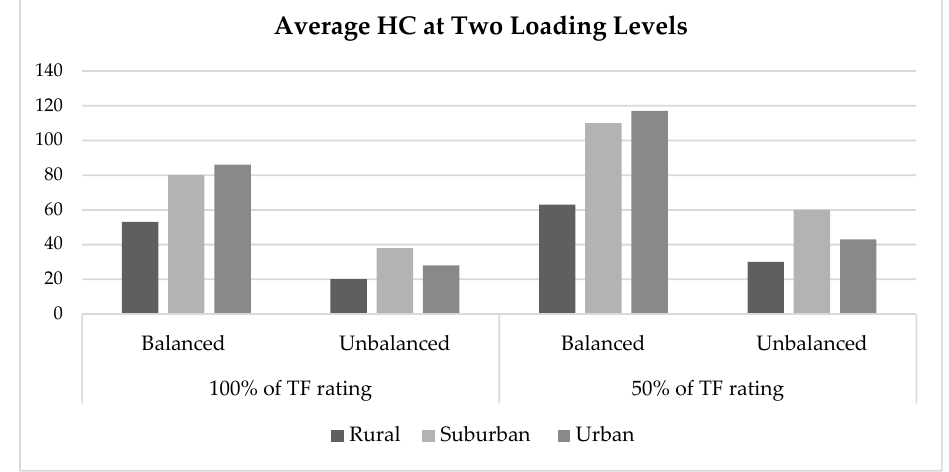
Figure 4. The average HC of three regions at different loading levels by averaging all percentage estimates of different reference definitions.